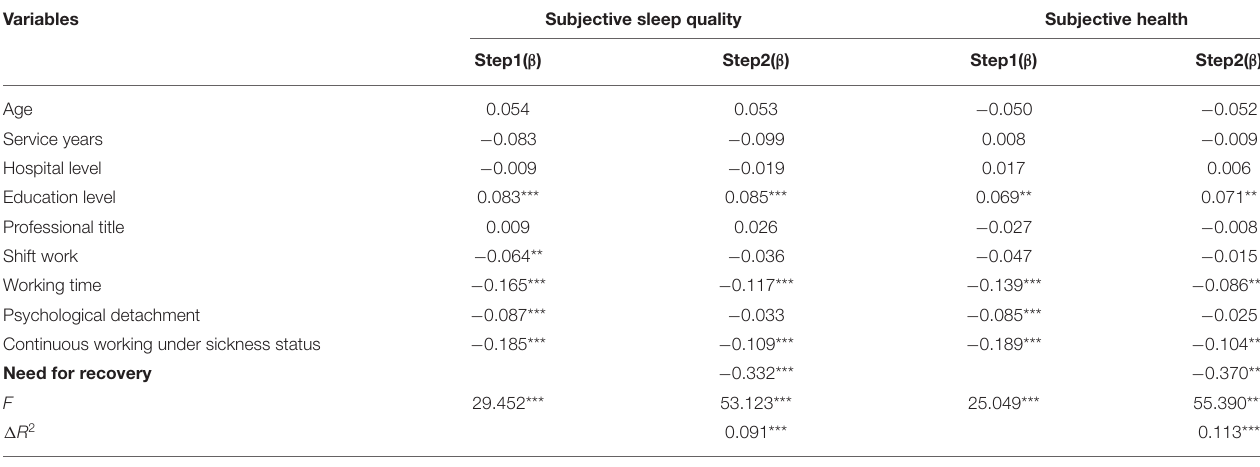
TABLE 5 | Hierarchical linear regression models for self-reported health